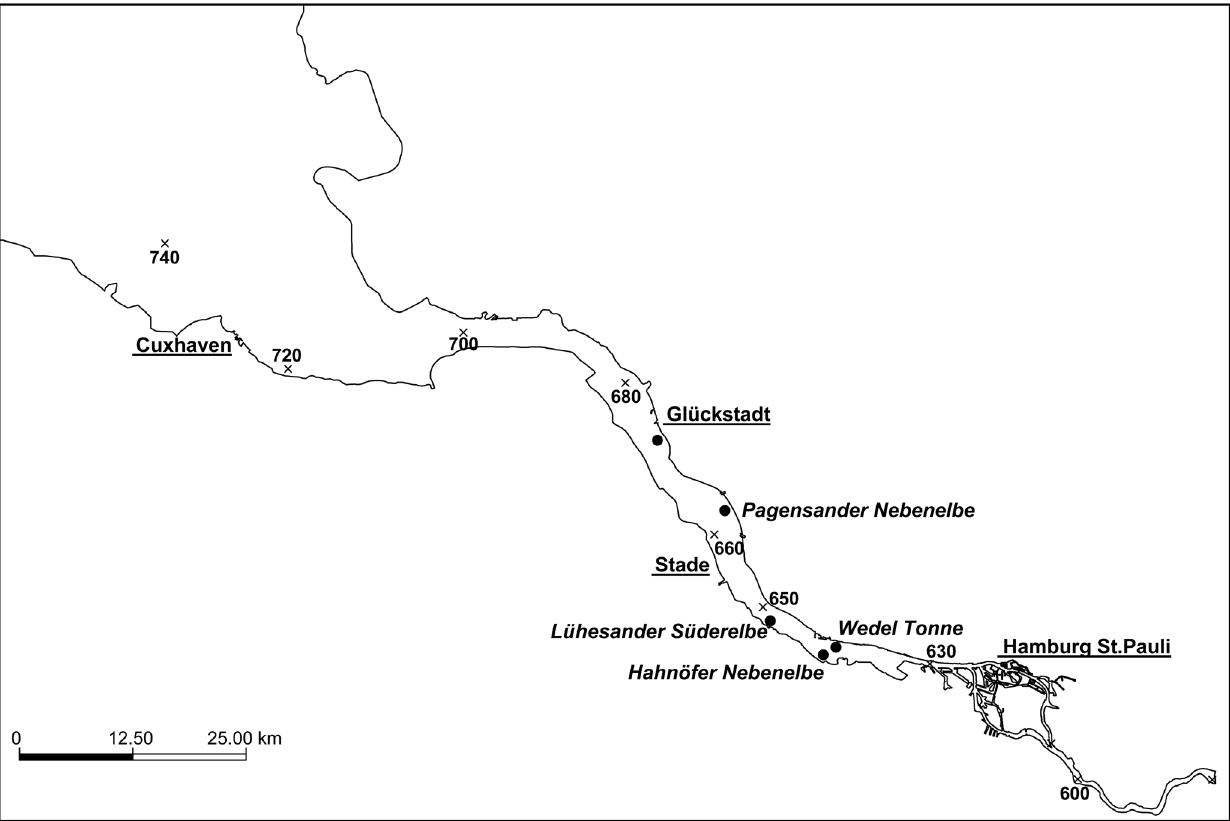
Figure 1. Map of the 140 km long Elbe estuary between Hamburg and Cuxhaven. Underlined names are cities along the estuary used as benchmarks. Names in italics identify the five sampling sites, which are additionally marked by black dots. Modified from Eick [99].